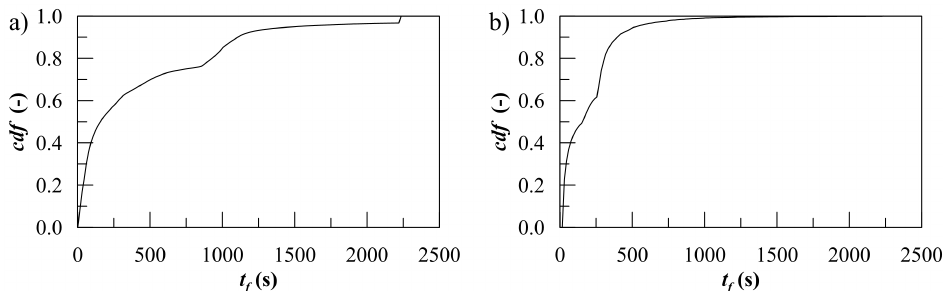
Figure 7. Comulative density function of the time-to-flood in the MC50b database for all damage cases ( a ) and for nonsurvival ones ( b